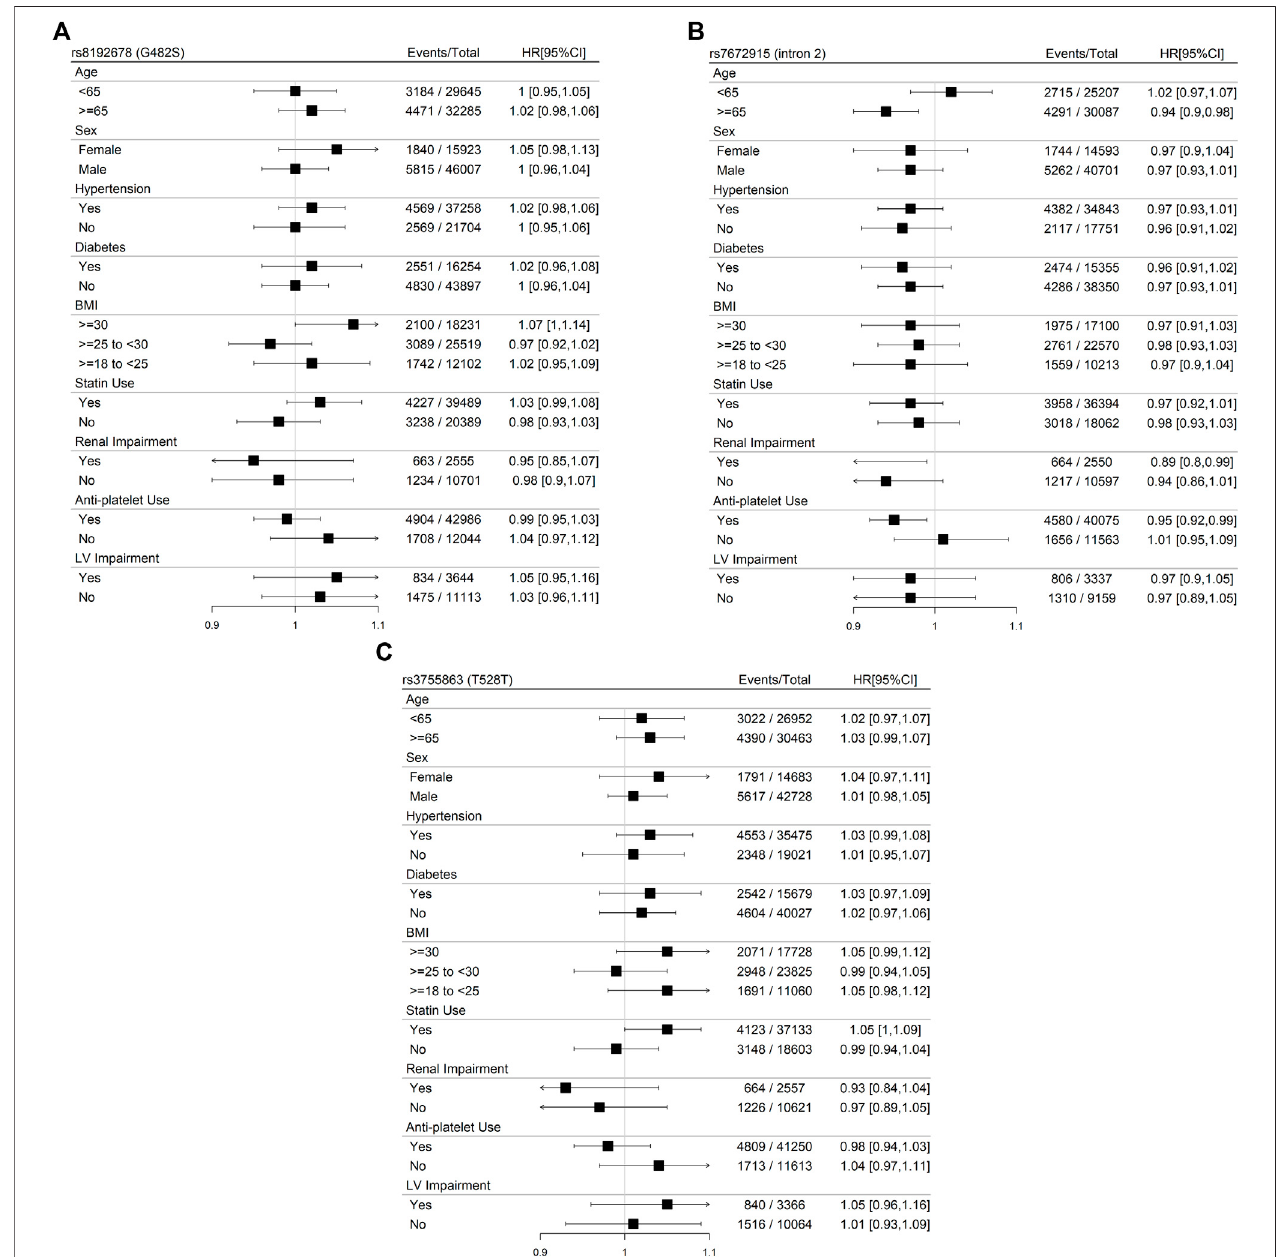
FIGURE5| Panel (A): Meta-analysesoftheassociationsbetweenrs8192673(G482S)inthe PPARGC1A geneandtheprimaryoutcome(CHDdeathormyocardial infarction) in participants with baselineCHD within GENIUS-CHD using an additive, fi xed-effectmodel strati fi ed for patient-level characteristics. LV, left ventricular. Panel (B): Meta-analyses of the associations between rs7672915 (intron 2) in the PPARGC1A gene and the primary outcome (CHD death or myocardial infarction) in participants with baseline CHD within GENIUS-CHD using an additive, fi xed-effect model strati fi ed for patient-level characteristics. LV, left ventricular. Panel (C): Meta-analyses of the associations between rs3755863 (T528T) in the PPARGC1A gene and the primary outcome (CHD death or myocardial infarction) in participants with baseline CHD within GENIUS-CHD using an additive, fi xed-effect model strati fi ed for patient-level characteristics. LV, left ventricular.